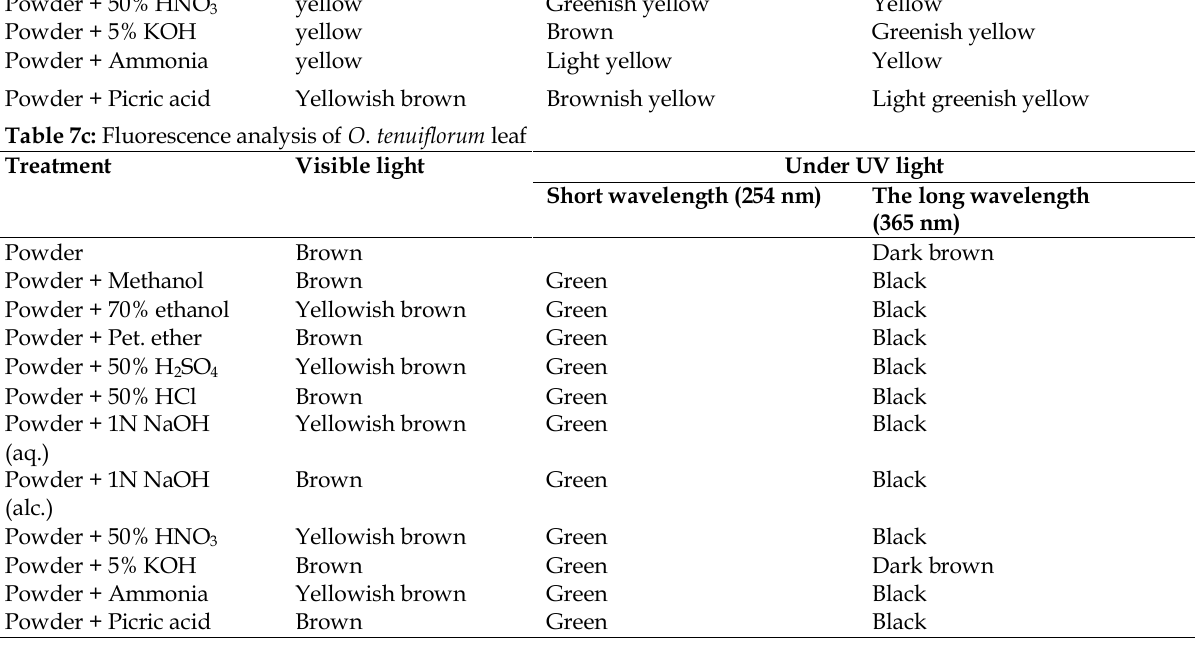
Table 7c: Fluorescence analysis of O . tenuiflorum